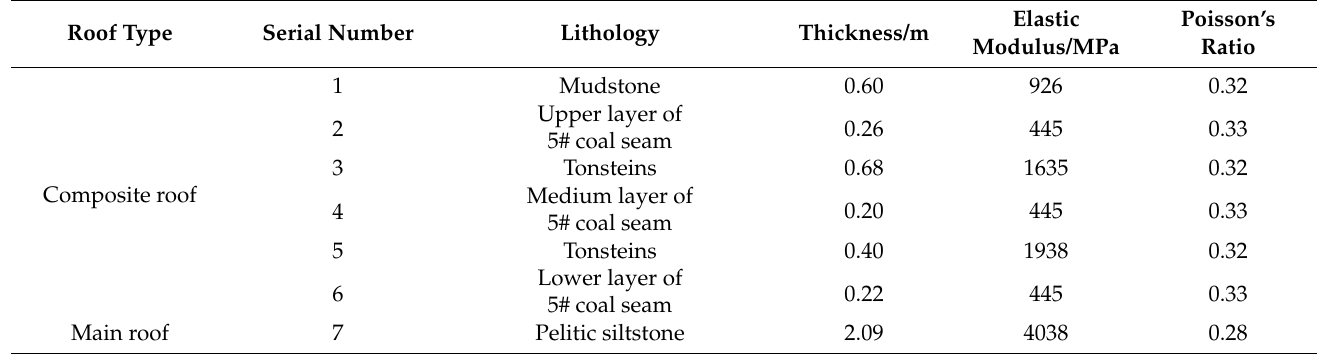
Table 1. Composition and parameters of composite roof.